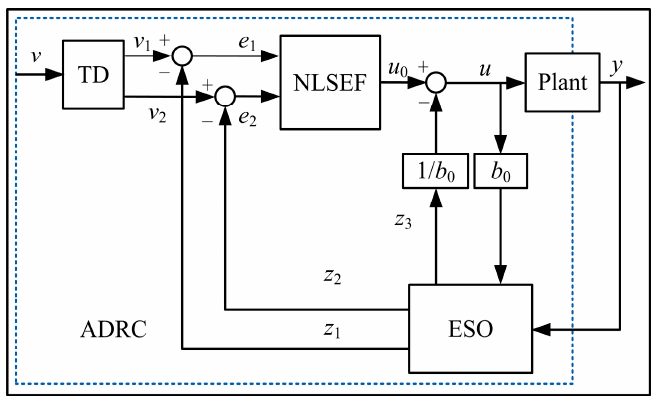
Figure 10. Basic topology of the ADRC.